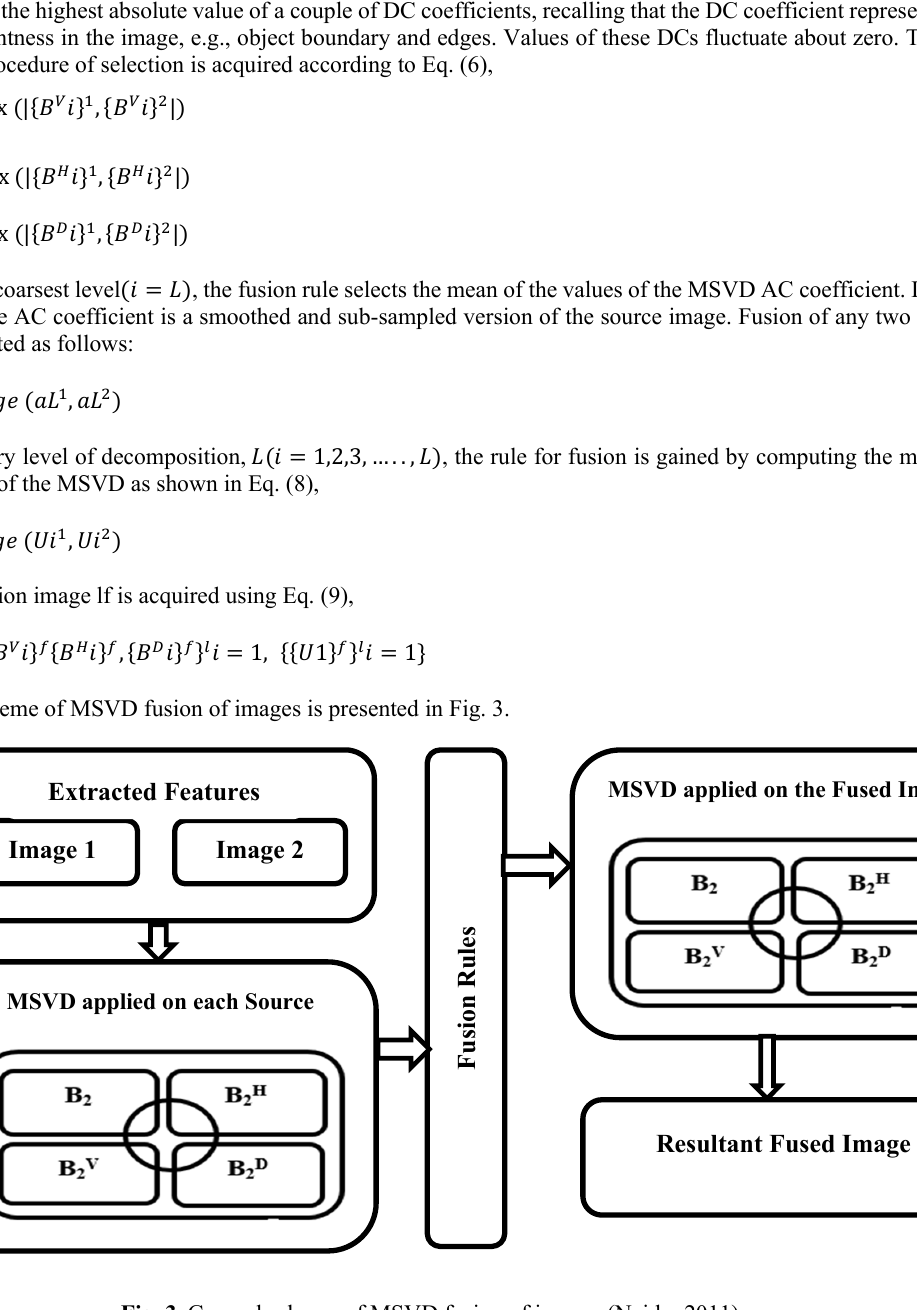
Fig. 3. General scheme of MSVD fusion of images (Naidu,